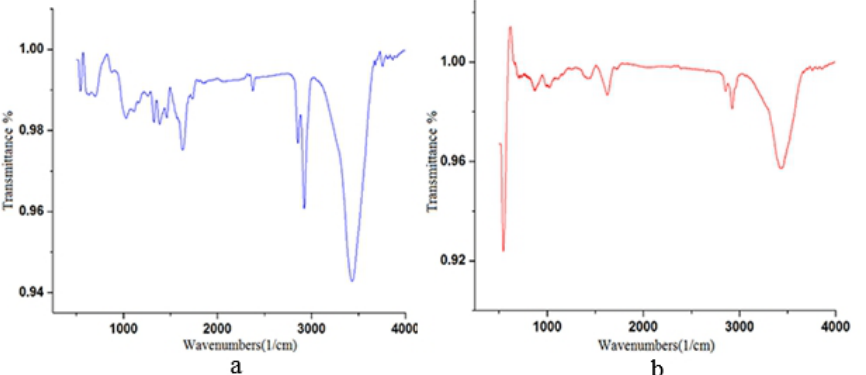
Fig. 4. FTIR images of nanoparticles: a) 1.0% molybdenum doped ZnO and b) undoped ZnO